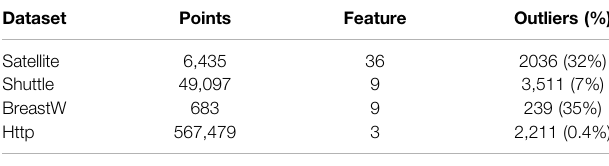
TABLE 1 | The details of outlier detection datasets.